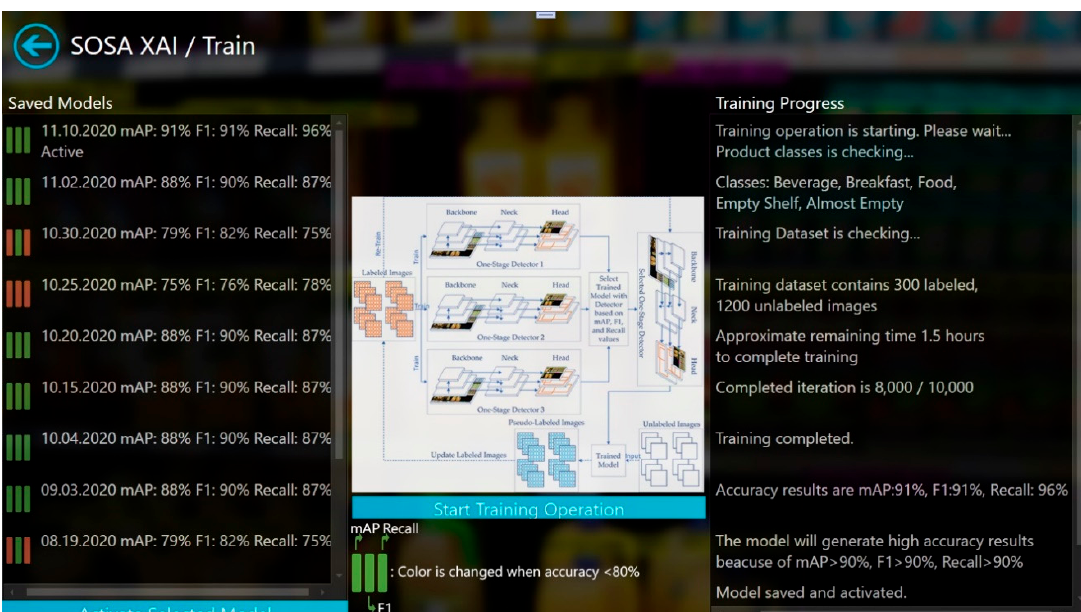
Figure 4. Train screen of SOSA XAI.